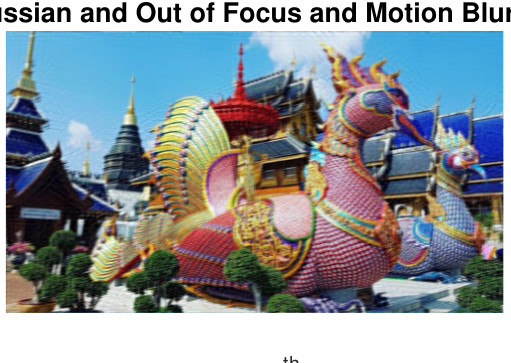
Figure 48. The reconstructed RGB image of all cases using the proposed method (2) with PSNR = 23.